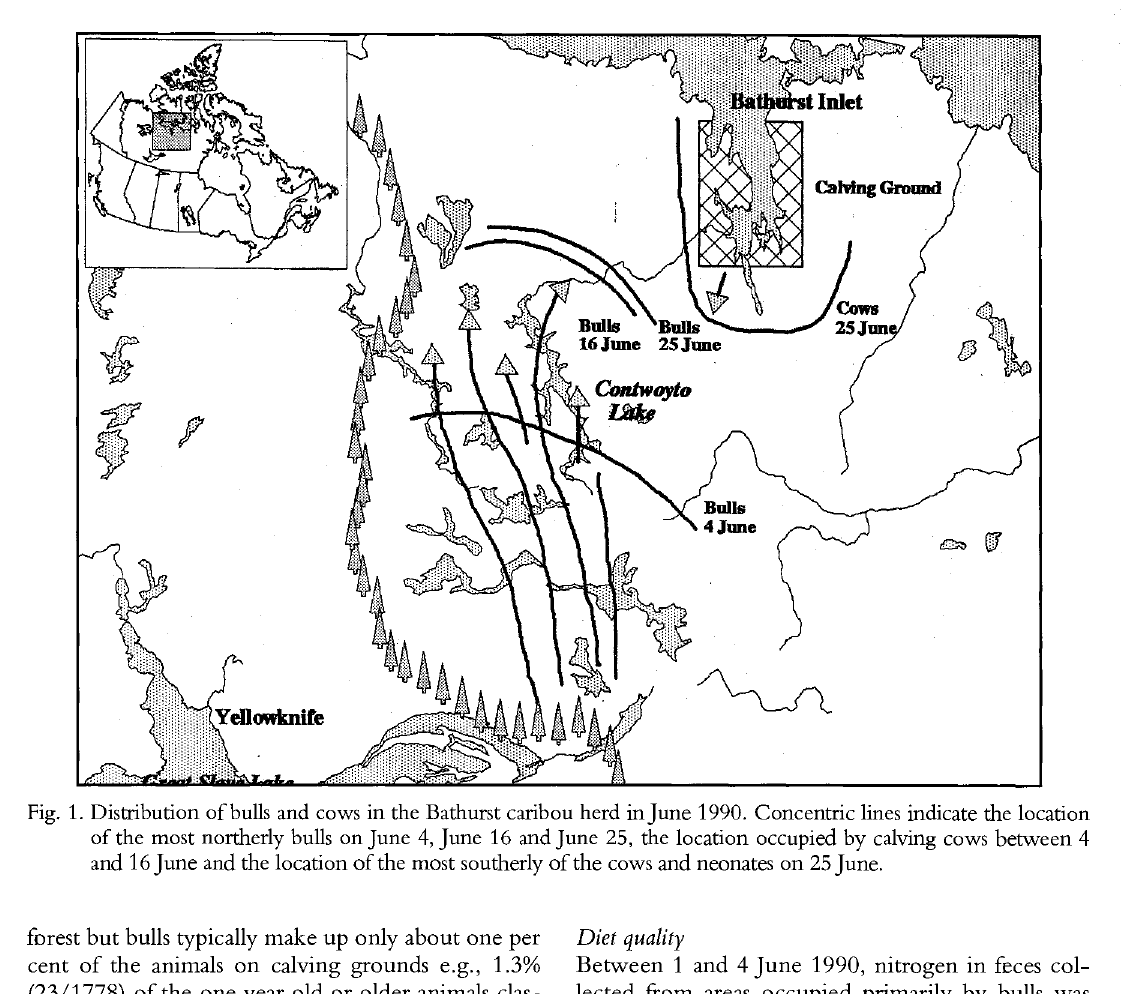
forest but bulls typically make up only about one per cent of the animals on calving grounds e.g.,